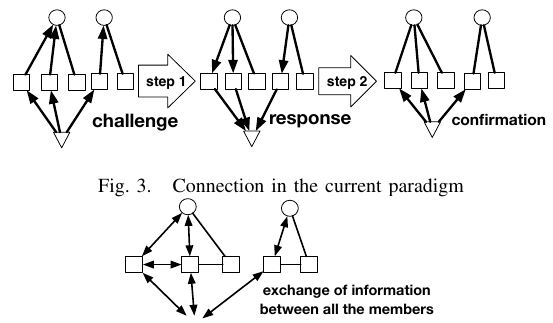
Fig. 3. Connection in the current paradigm